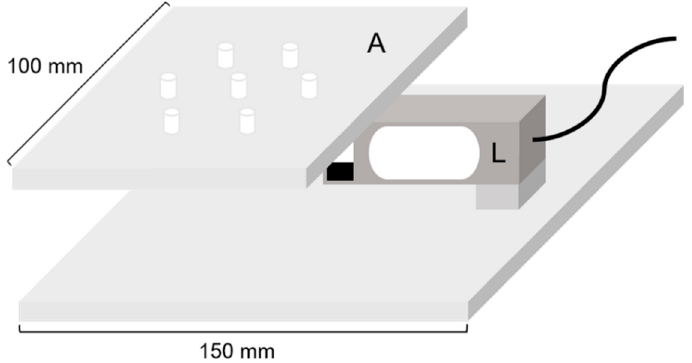
Figure 2. Diagram of the load cell. Pots were mounted on the acrylic plates attached to the load cells, and the leaching water was drained through the holes in the plate. A, acrylic plate; L, load cell.